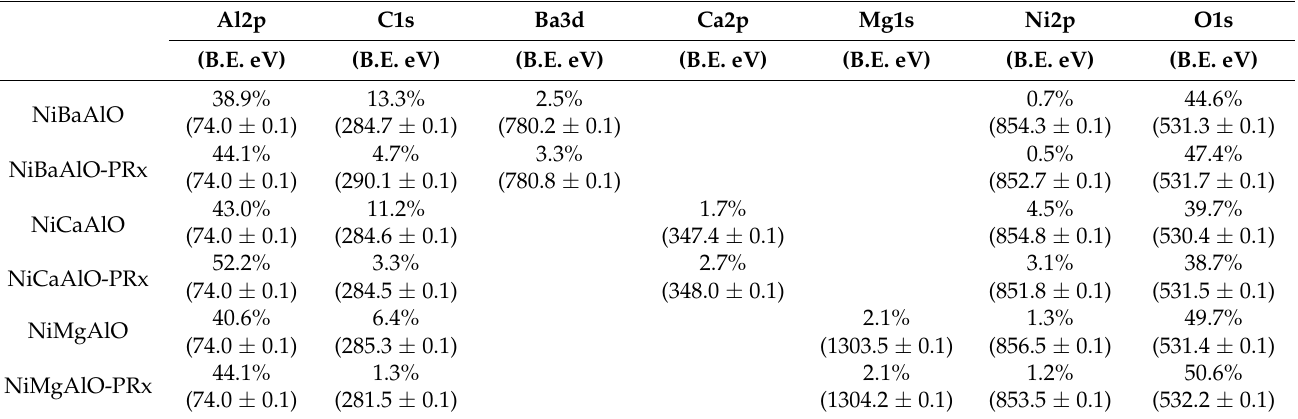
Table 4. Calculated surface % area for the indicated elements obtained from XPS and peaks maxima for NiBaAlO, NiMgAlO, and NiCaAlO samples.